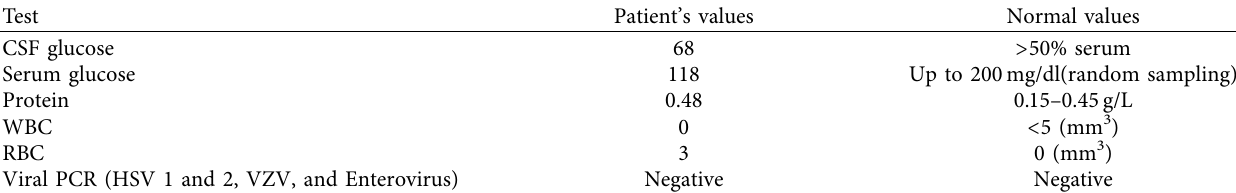
Table 2: CSF analysis